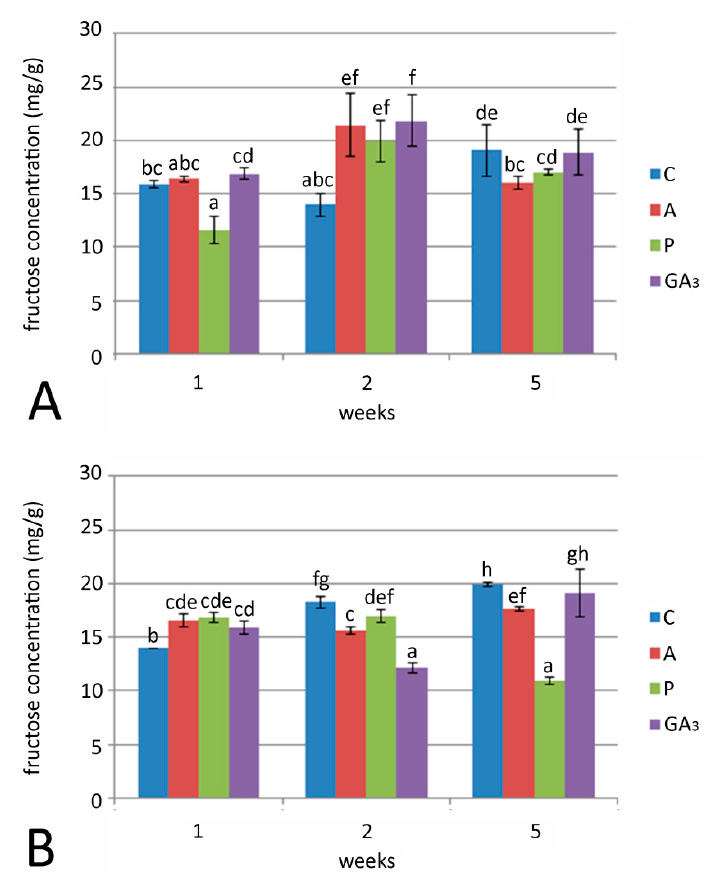
Figure4. E ff ectofGA 3 andGAinhibitors: ancymidol(A)andpaclobutrazol(P)onfructoseconcentration Figure 4. Effect of GA 3 and GA inhibitors: ancymidol (A) and paclobutrazol (P) on fructose in F. meleagris bulbs cultured for 1, 2 and 5 weeks at 24 ◦ C ( A ) and 7 ◦ C ( B ). C—bulbs cultured on concentration in F. meleagris bulbs cultured for 1, 2 and 5 weeks at 24 °C ( A ) and 7 °C ( B ). C—bulbs medium without PGR; di ff erent letters indicate significant di ff erences between treatments at p < 0.05 cultured on medium without PGR; different letters indicate significant differences between (LSD treatments at p < 0.05 (LSD test).